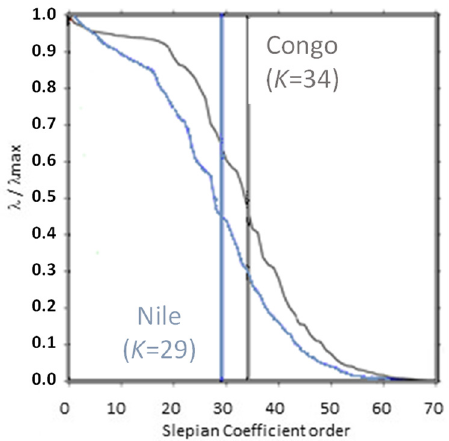
Figure 2. Normalized eigenvalue spectra computed from the geographical masks of the Congo and Nile river drainage basins. Shannon numbers K are also indicated (blue line for Nile, grey one for Congo). For the Nile basin around 20% of the normalized energy is not taken into account if the K truncation is used by comparing to the K opt . The overall increase in the number of coefficients, which constitutes the basis of SF, corresponds to ~165% ( K = 29 versus K opt = 77) for the Nile, and the loss of information is ~12% lower for the Congo and is again marked by a strong increase in the number of SF coefficients of about ~130% ( K = 34 versus K opt =